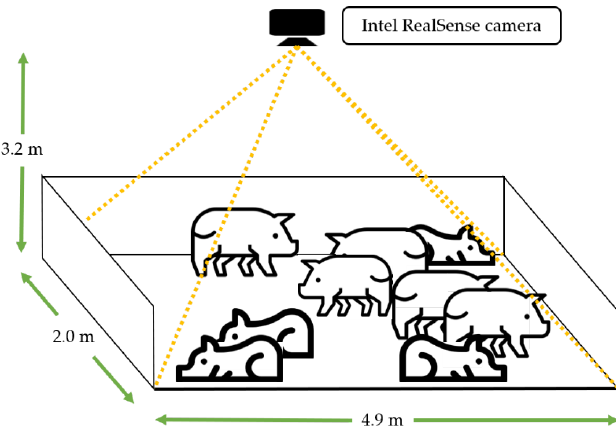
Figure 5. Experimental setup with Intel RealSense low-cost camera.